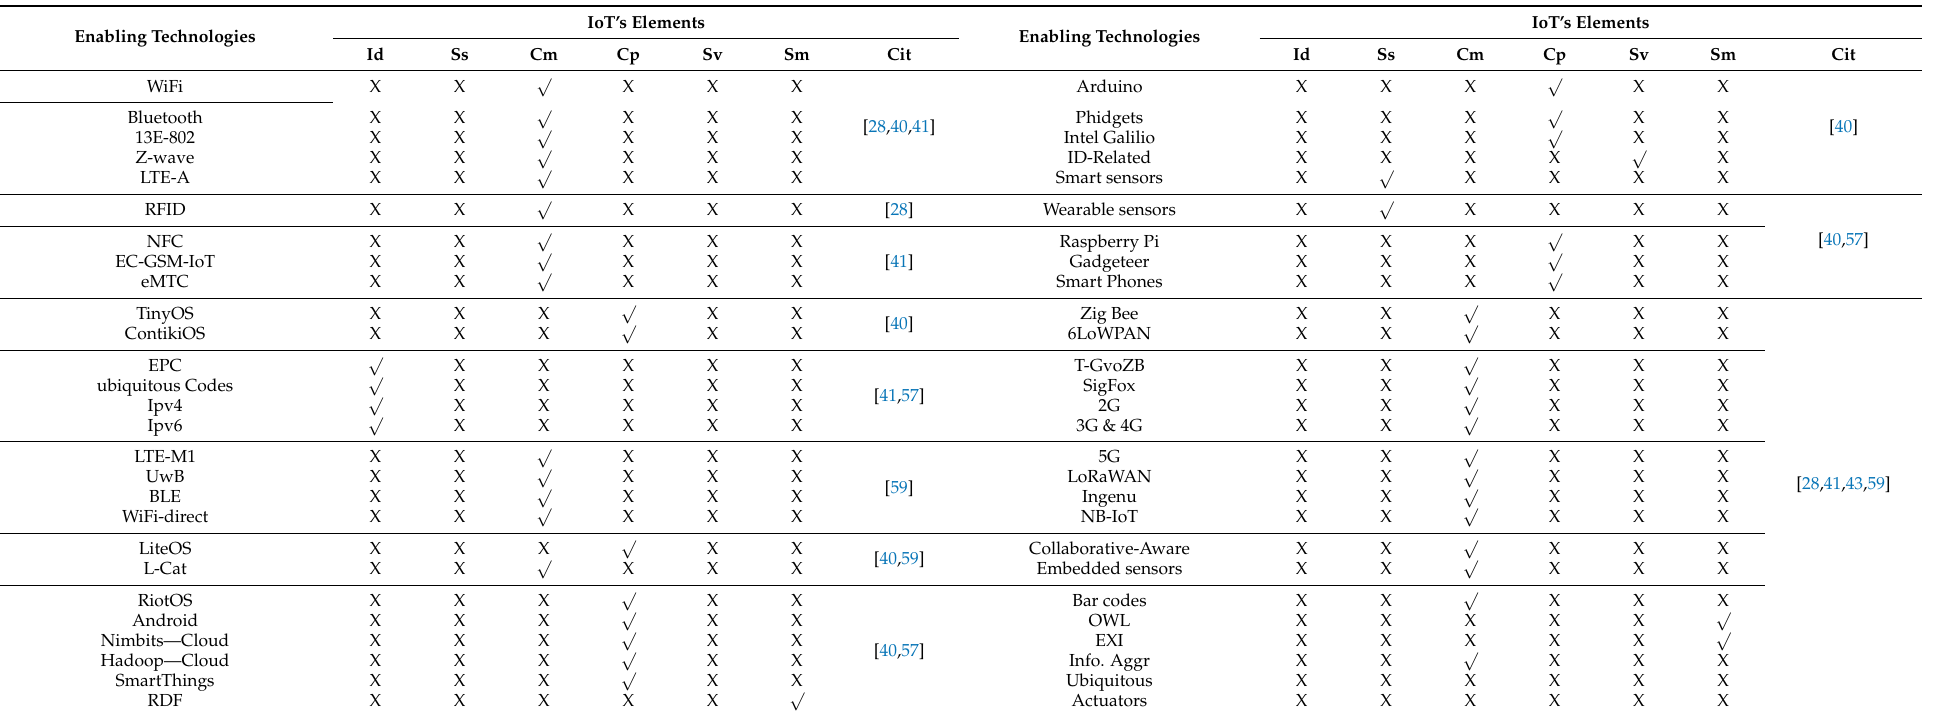
Table 3. Type of enabling technologies for IoT and based on its